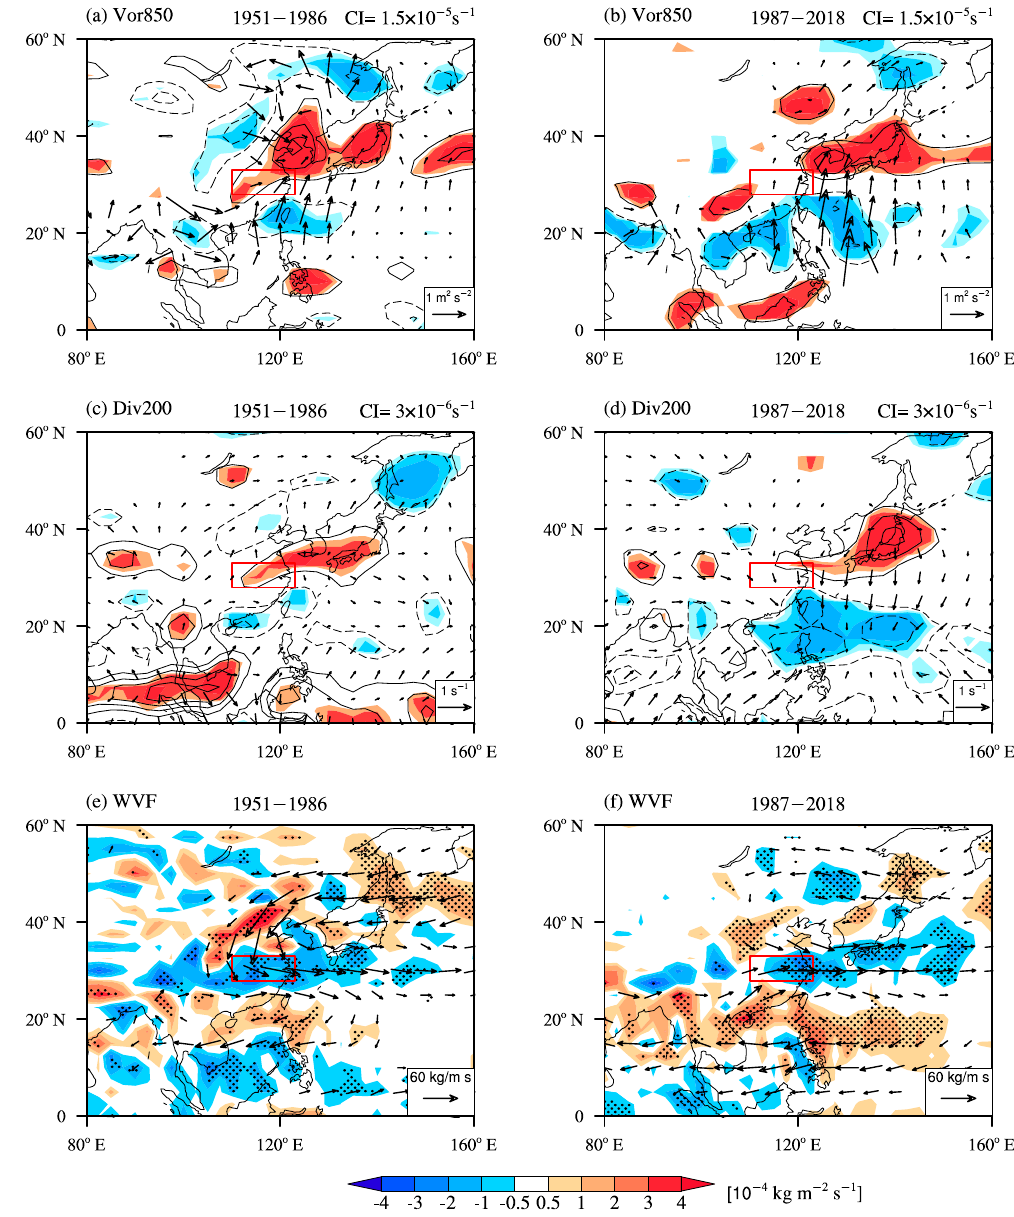
Figure 3. ( a , b ) Regression maps of the JJA relative vorticity (contour; unit: s − 1 ) and the associated wave activity flux (vector; unit: m 2 s − 2 ) at 850 hPa with respect to the normalized EAP index (multiplied by − 1.0) for 1951–1986 and 1987–2018, respectively. ( c , d ) Same as for ( a , b ) but for the divergence (contour; unit: s − 1 ) and the divergent wind (vector; m s − 1 ) at 200 hPa. ( e , f ) Same as for ( a , b ) but for the water vapor flux integration of 1000–300 hPa (vector; unit: kg m − 1 s − 1 ) and its divergence (shading; unit: 10 − 4 kg m − 2 s − 1 ). In (a–d), positive (negative) values are indicated by solid (dashed) contours with the zero contour omitted. The three orange (blue) shadings from shallow to deep in ( a – d ) indicate that positive (negative) anomalies are significant at the 90%, 95%, and 99% confidence levels based on a two-tailed Student’s t test, respectively. The dotted regions in ( e – f ) indicate the 90% confidence level based on Student’s t test. The red boxes indicate the YH-R basin.